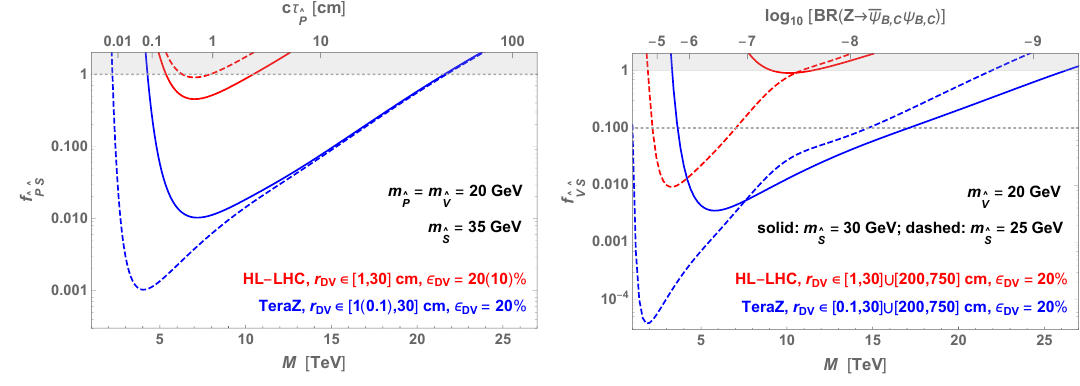
Figure 5 . Left: projected bounds on f ^ from future searches for Z ! ^ P ^ S , where ^ P is long-lived P ^ S while ^ S ! ( ^ V ! ‘‘ ) f (cid:22) f . Right: projected bounds on f ^ from future searches for Z ! ^ V ^ S , where V ^ S ^ S is long lived while ^ V ! ‘‘ . All bounds are at 95% CL, assuming negligible SM background. We take ‘ = (cid:22) ( e or (cid:22) ) at the LHC (TeraZ), and the dilepton pair must be prompt at the LHC, but can be displaced at TeraZ. The dotted gray lines correspond to the educated guesses f ^ (cid:24) 1 ; 0 : 1 P ^ S; ^ V ^ S discussed in subsection